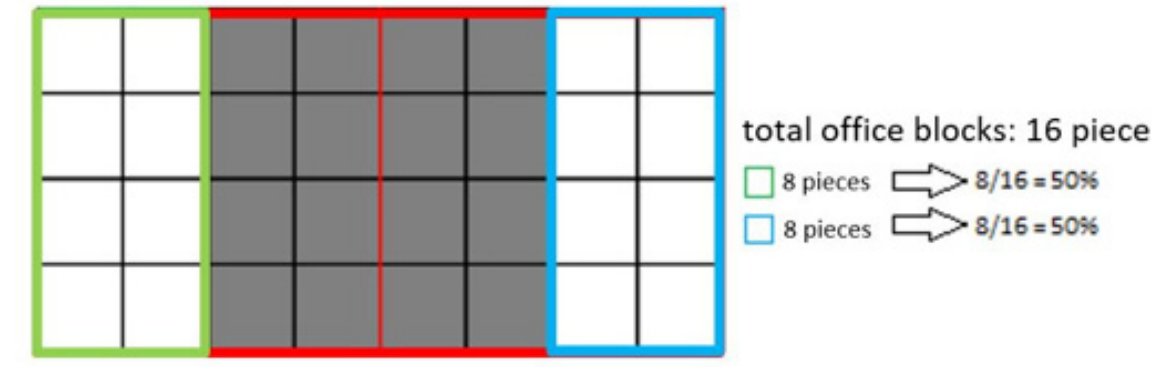
Figure 9. Determination of office block sizes.